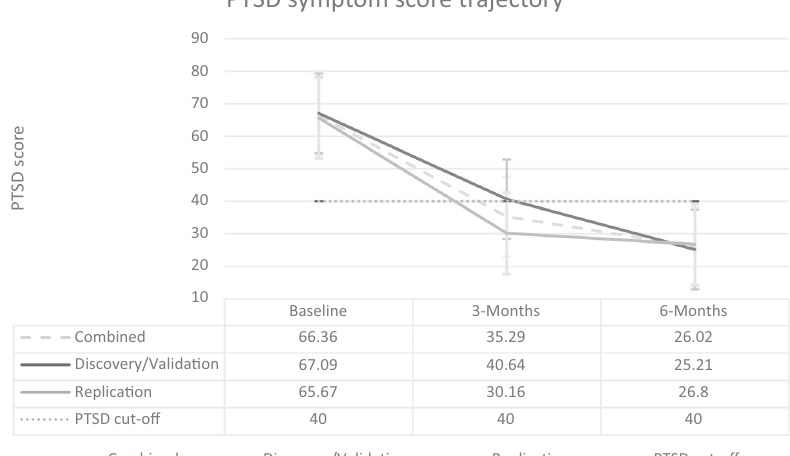
Fig. 3 Posttraumatic stress disorder (PTSD) symptom trajectory. Symptoms over 6 months for the discovery/validation samples, replication sample, and combined